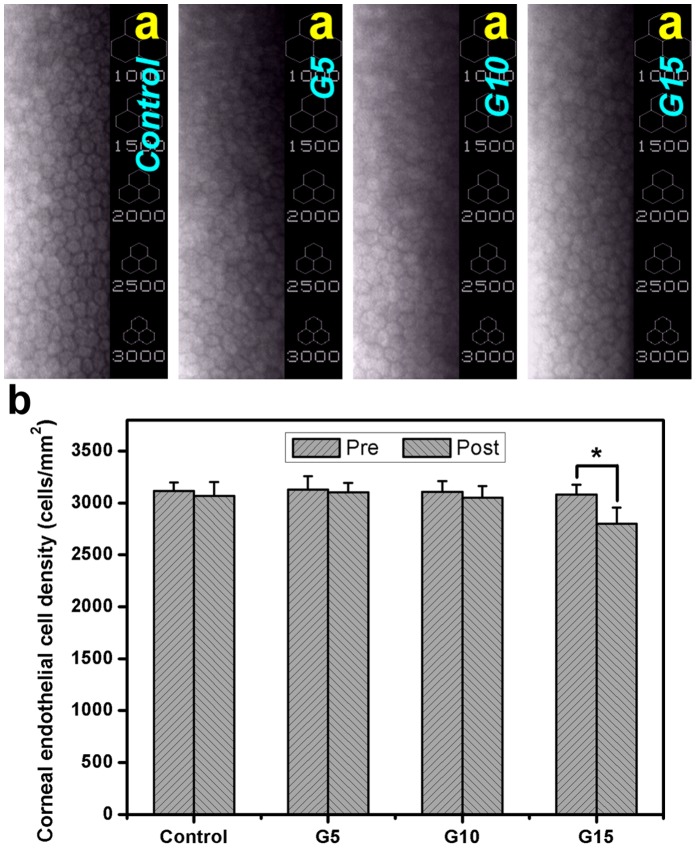
In vivo studies.Specular microscopy measurements of rabbit corneal endothelium 3 days after surgical insertion of various gelatin implants in the ocular anterior chamber. (a) Typical images; (b) graph of corneal endothelial cell count. An asterisk indicates statistically significant differences (*P<0.05; n = 6) between the preoperative (Pre) and postoperative (Post) cell density for each type of gelatin disc. The rabbits received no implant (only corneal/limbal incision) and served as a control (sham-operated) group.